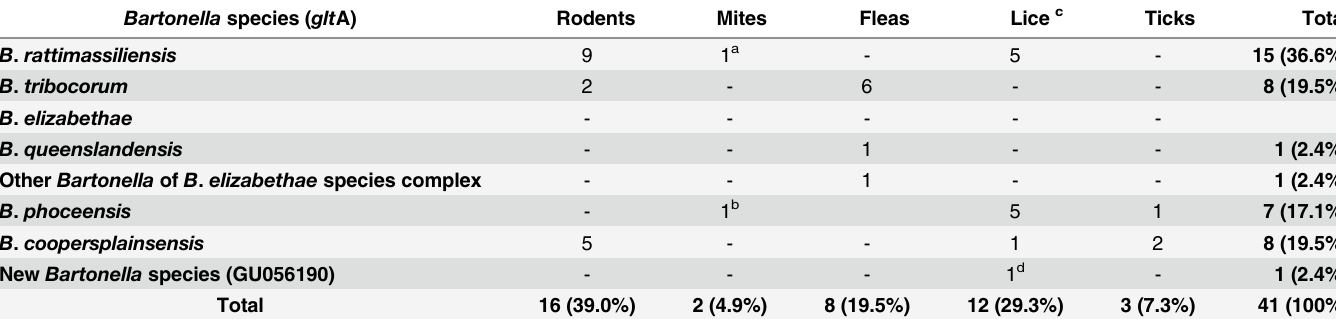
Table 5. Bartonella species identified in rodents and their associated ectoparasites based on glt A gene sequence similarities Bartonella species ( glt